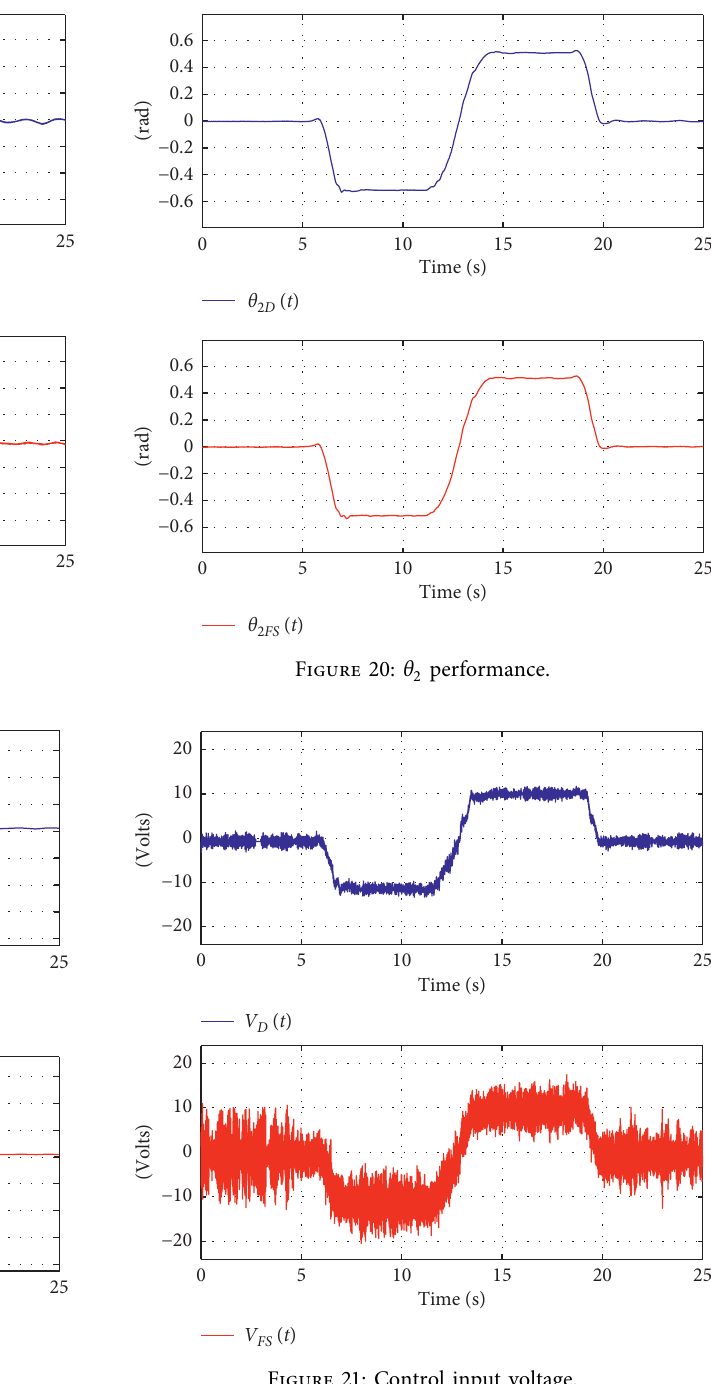
Figure 19: θ performance. 1